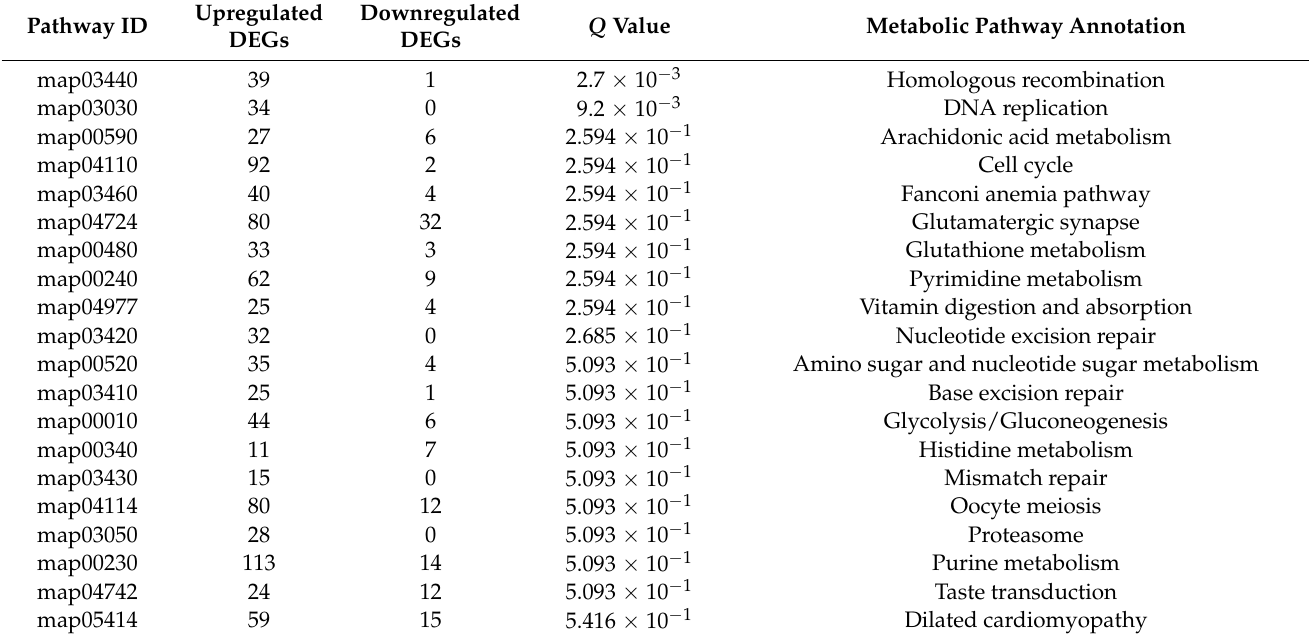
Table 3. Top 20 KEGG metabolic pathways for MP-group vs control